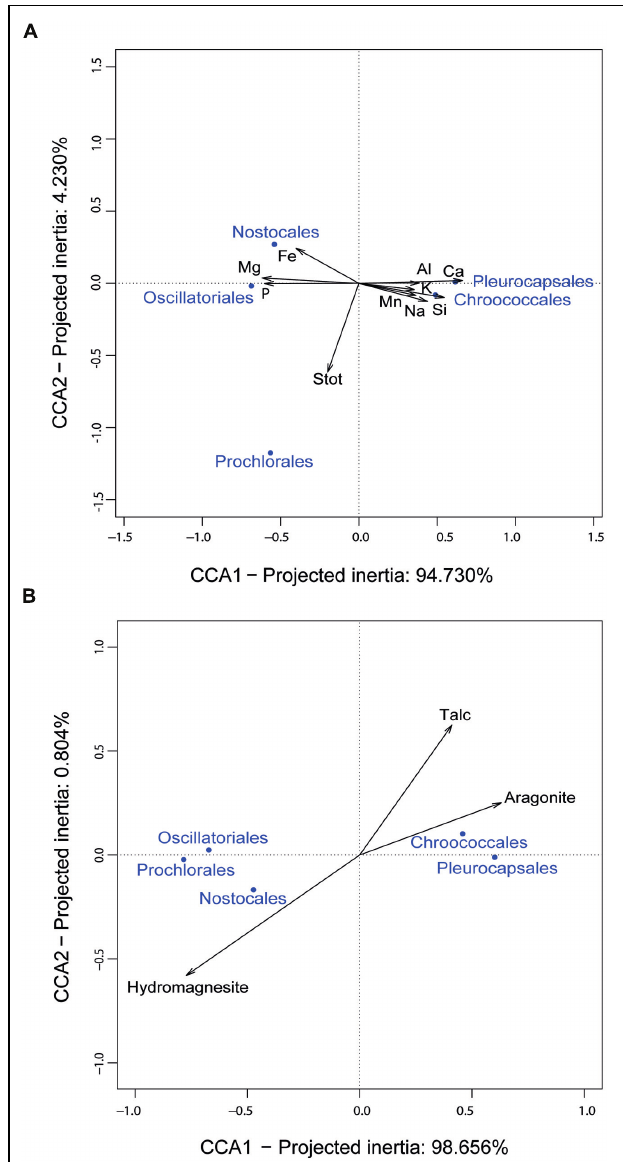
FIGURE 6 | Canonical Correspondence Analysis (CCA) of 16S rRNA gene sequence frequencies of dominant cyanobacterial taxa and chemical parameters of Alchichica microbialites. (A) CCA including the elemental composition of microbialites; (B) CCA including the mineral composition of